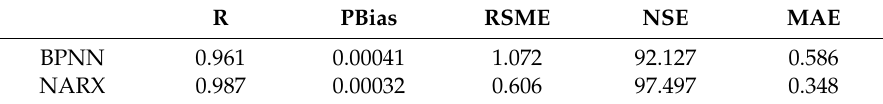
Table 6. Average value of modeling results using the two di ff erent networks.